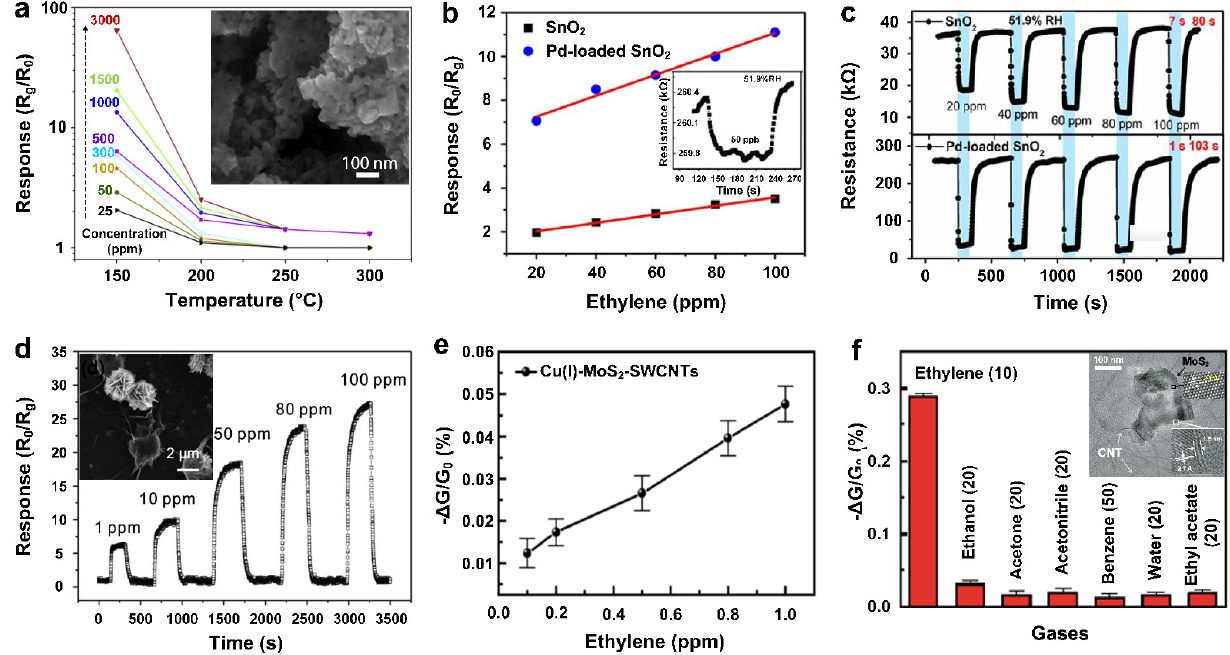
Figure 9. ( a ) Sensing response of nanostructured LaFeO 3 -based sensor toward ethylene gas of various concentrations at different temperatures. Inset: SEM image of nanostructured LaFeO 3 . Reproduced from Ref. [54] with permission from Elsevier. ( b ) Comparison of ethylene gas-sensing response to its concentration for the devices loaded with (bule dots) and without (black squares) Pd nanoparticles. Inset: the sensing curve of 50 ppb ethylene gas when using Pd-SnO 2 (inset). ( c ) The dynamic curves of SnO 2 -based ethylene gas sensors loaded with (bottom) and without (top) Pd nanoparticles at different concentrations. Reproduced from Ref. [28] with permission from Elsevier. ( d ) The response curve against ethylene gas of different concentration. Inset: SEM image of the Pd/rGO/α-Fe 2 O 3 nanostructure. Reproduced from Ref. [56] with permission from Elsevier. ( e ) The function of response to ethylene gas concentration and ( f ) the selectivity towards ethylene gas detection among other different VOCs by using the nanocomposite of Cu(I)-MoS 2 -SWCNTs. Inset: the morphology of the MoS 2 -SWCNT nanocomposite under SEM and HRTEM. Reproduced from Ref. [84] with permission from the American Chemical Society.